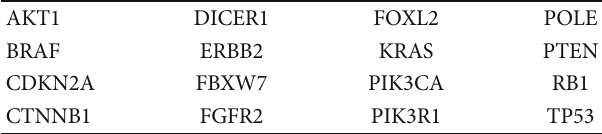
Figure 3: Microscopic view: cystic tumor with papillae lined by pseudo- or pluristrati fi ed atypical epithelium (hematoxylin and eosin) ( × 10). Table 1: Cancer hotspot panel used by next-generation sequencing.